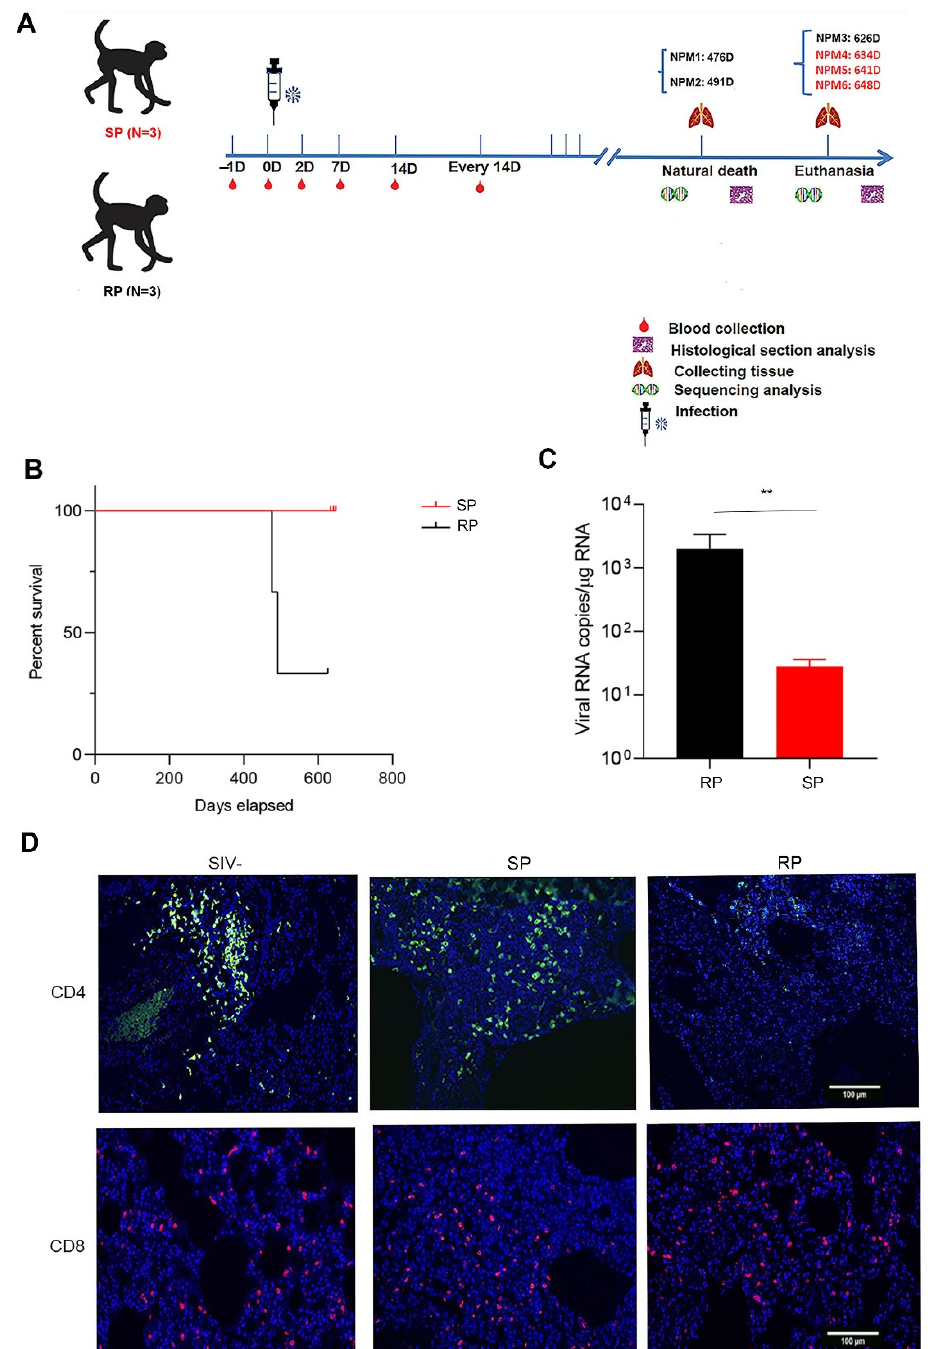
Figure 1. Viral load and changes in T cells in the lungs during chronic infection. ( A ) Schematic of the study. Blood samples were collected twice in the first week after infection, once in the second week after infection, and once every 14 days for the remainder of the time. The animals that died naturally were dissected immediately, and lung tissue was collected. The other animals were euthanized. SP: n = 3, RP: n = 3. ( B ) Survival curves of the two groups. ( C ) Viral load in the lungs. ( D ) Changes in T lymphocytes in the lungs before and after infection with SIVmac239 (blue: DAPI; green: CD4; red: CD8). Representative figures were selected randomly. Slow progressors/SP: n = 3, Rapid progressors/RP: n = 3, Healthy/SIV-: n = 4. The bars and error bars indicate the means ± SEMs. Paired t tests were used to compare groups. ** p < 0.01.